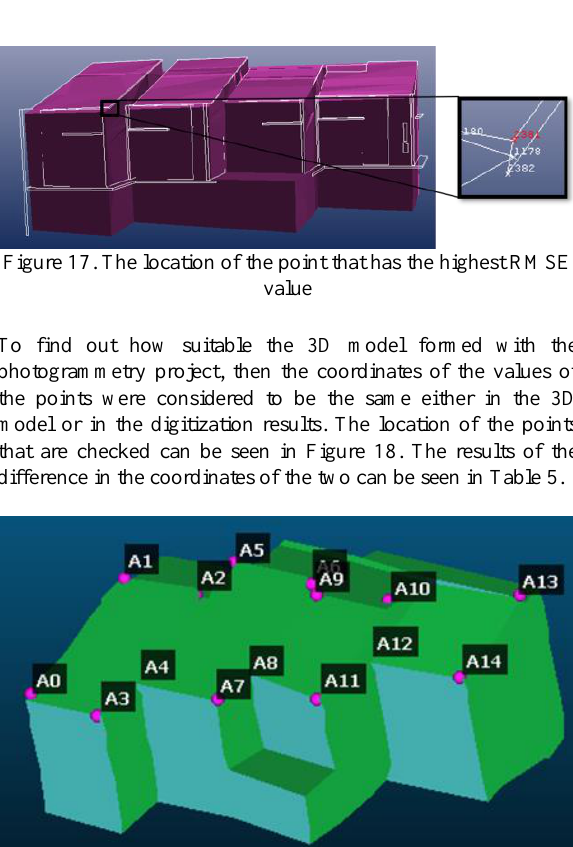
Figure 18. Check point location